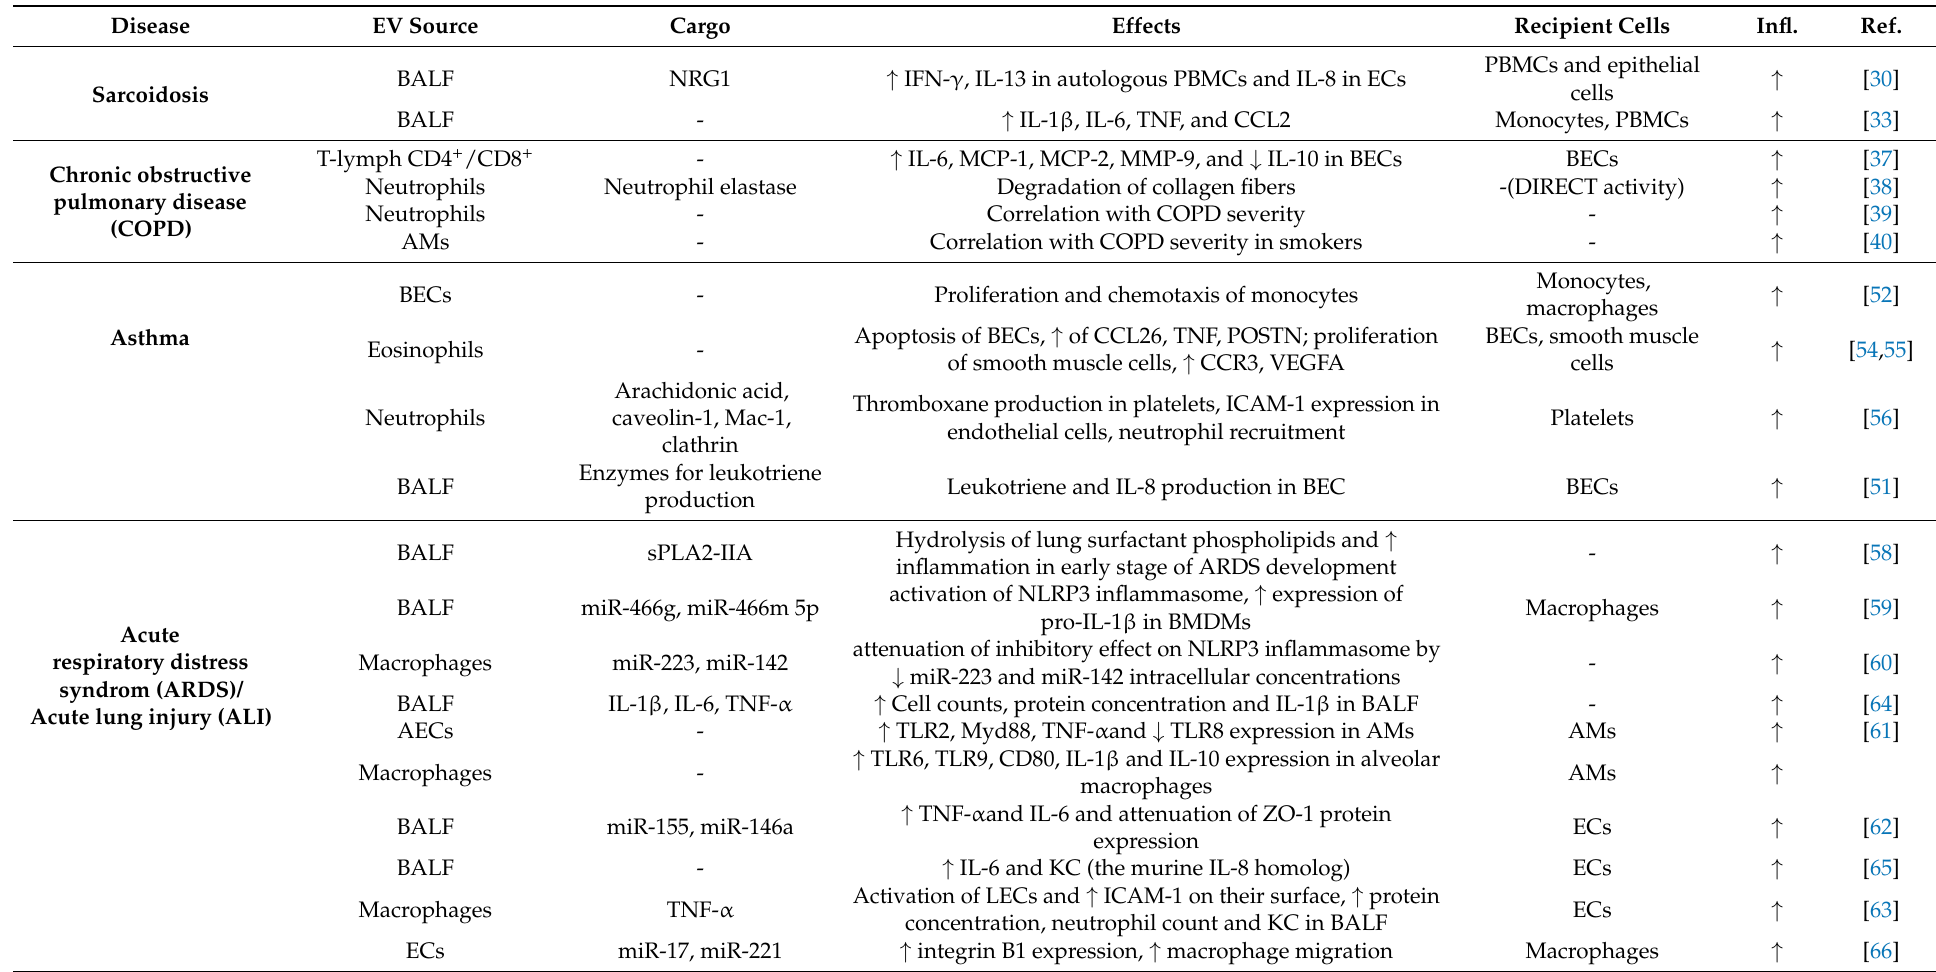
Table 1. Impact of EVs found in bronchoalveolar lavage fluid (BALF) in different lung diseases on